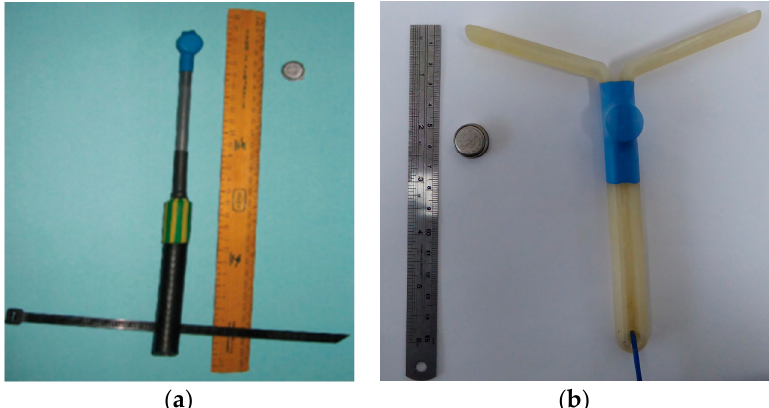
Figure 1. Design of the ( a ) i ntra-rectal data loggers as described by Lea et al. [22] and ( b ) i ntra-vaginal data loggers.